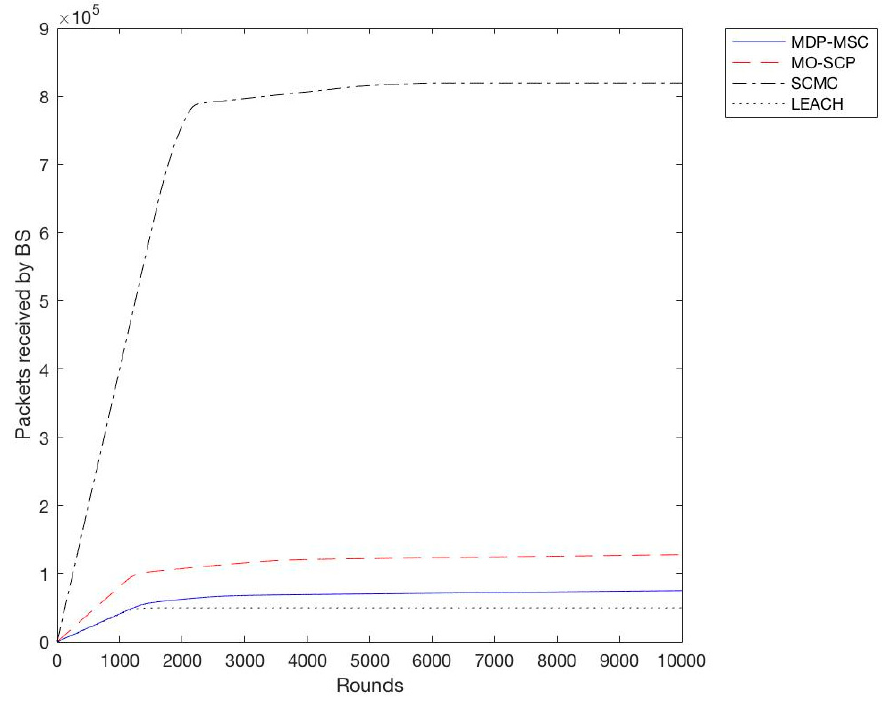
Figure 9. Throughput comparison of SCMC, MO-SCP, MDP-MSC and LEACH. (Size = 400).